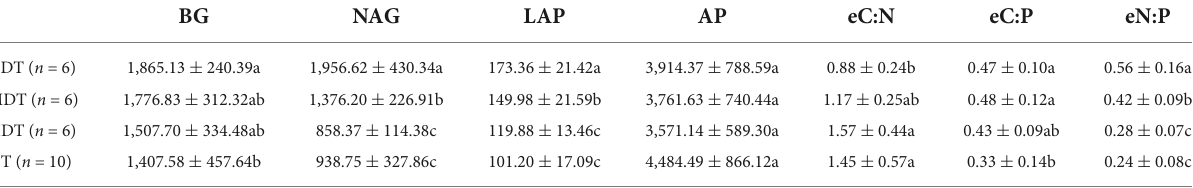
TABLE 2 The selected soil extracellular enzyme activities and enzymatic stoichiometry for different types of karst tiankeng.